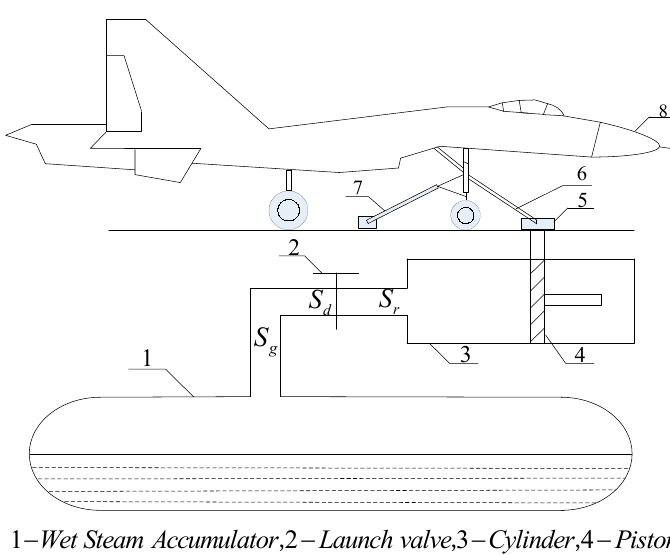
Figure 1. The general steam ‐ powered catapult launch system for carrier ‐ based aircraft.